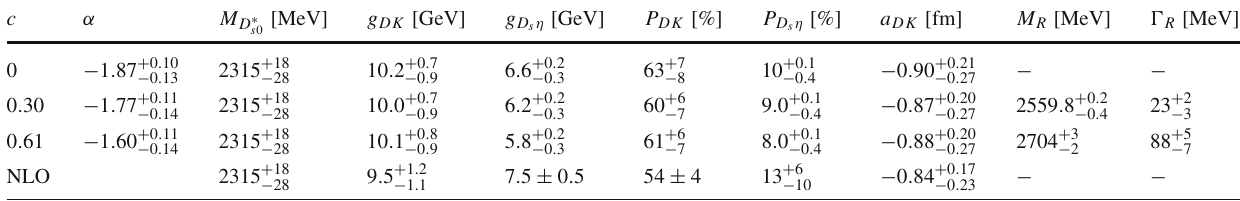
Table 6 Same as Table 5, but using a different procedure to renor- malize the meson loop matrix G ( s ) . Here, as in Refs. [48,49], we have used dimensional regularization with a subtraction constant α (see